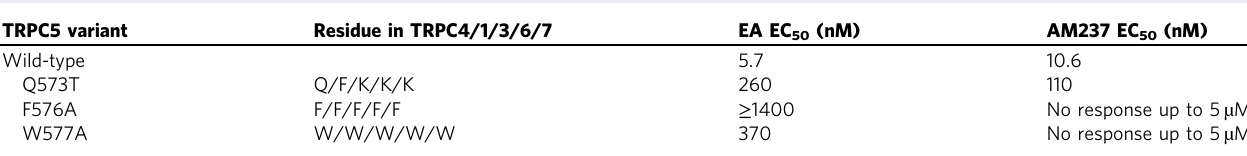
Table 2 Summary of data in Fig.